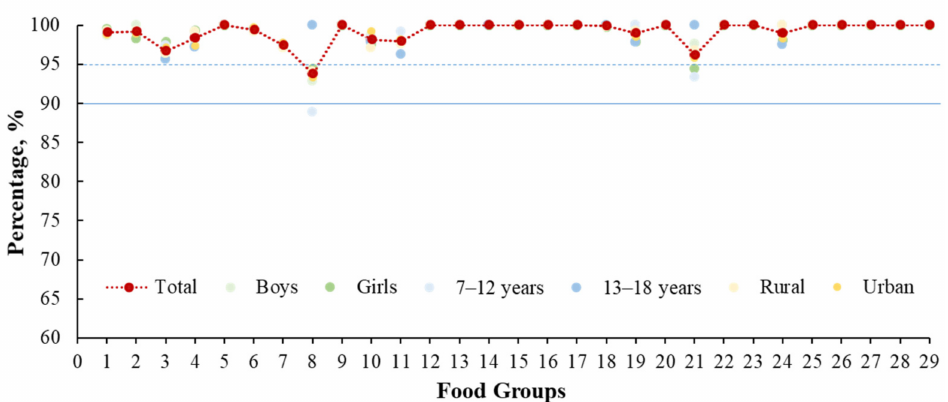
Figure 2. Percentage (%) of the consumption of sentinel food items compared with all food items in respective 29 food groups by sex, age, and residence. Note: 1: Staple foods made from grains; 2: Whole grains; 3: White root/tubers; 4: Legumes; 5: Vitamin A-rich orange vegetables; 6: Dark green leafy vegetables; 7: Other vegetables; 8: Vitamin A-rich fruits; 9: Citrus; 10: Other fruits; 11: Grain-baked